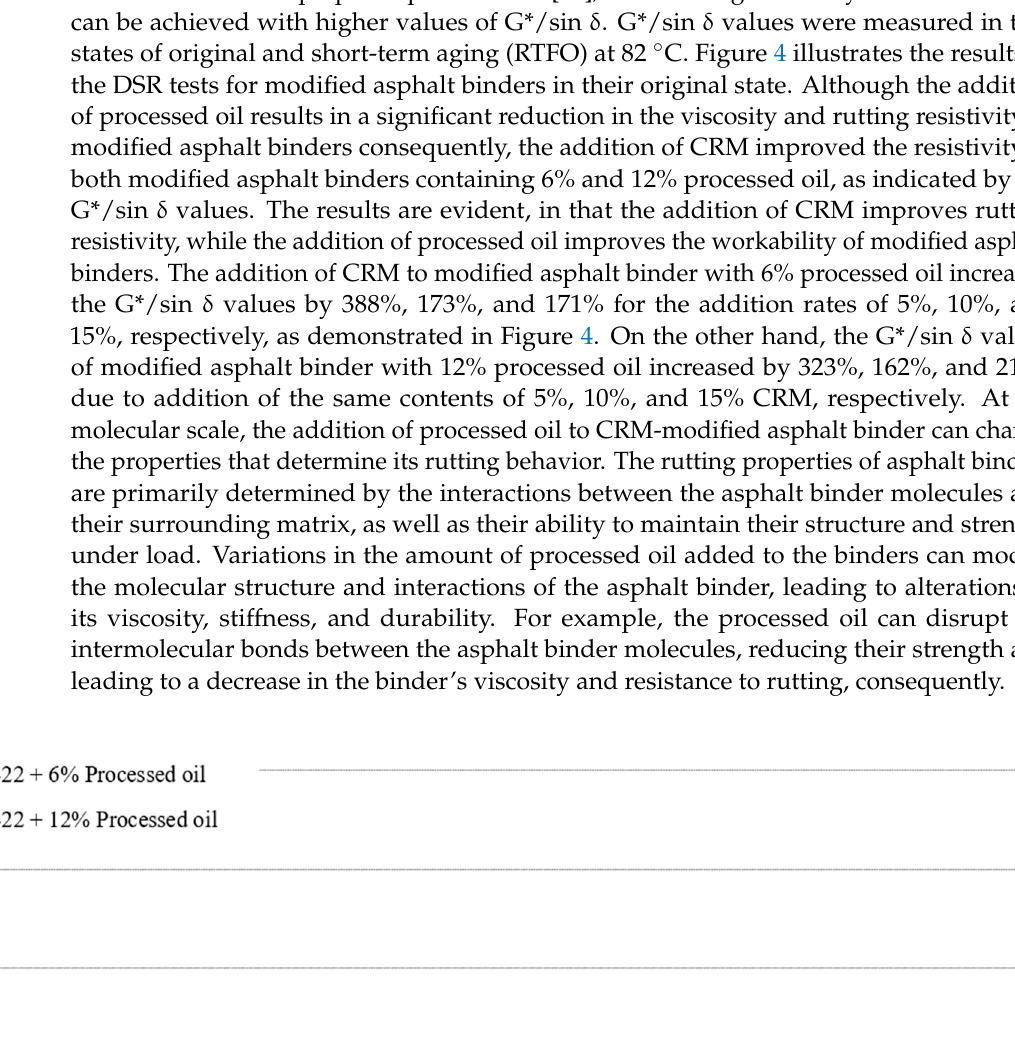
Table 6. Statistical analysis results of G*/sin δ for PG 64-22, with processed oil as a function of CRM content ( α = 0.05).